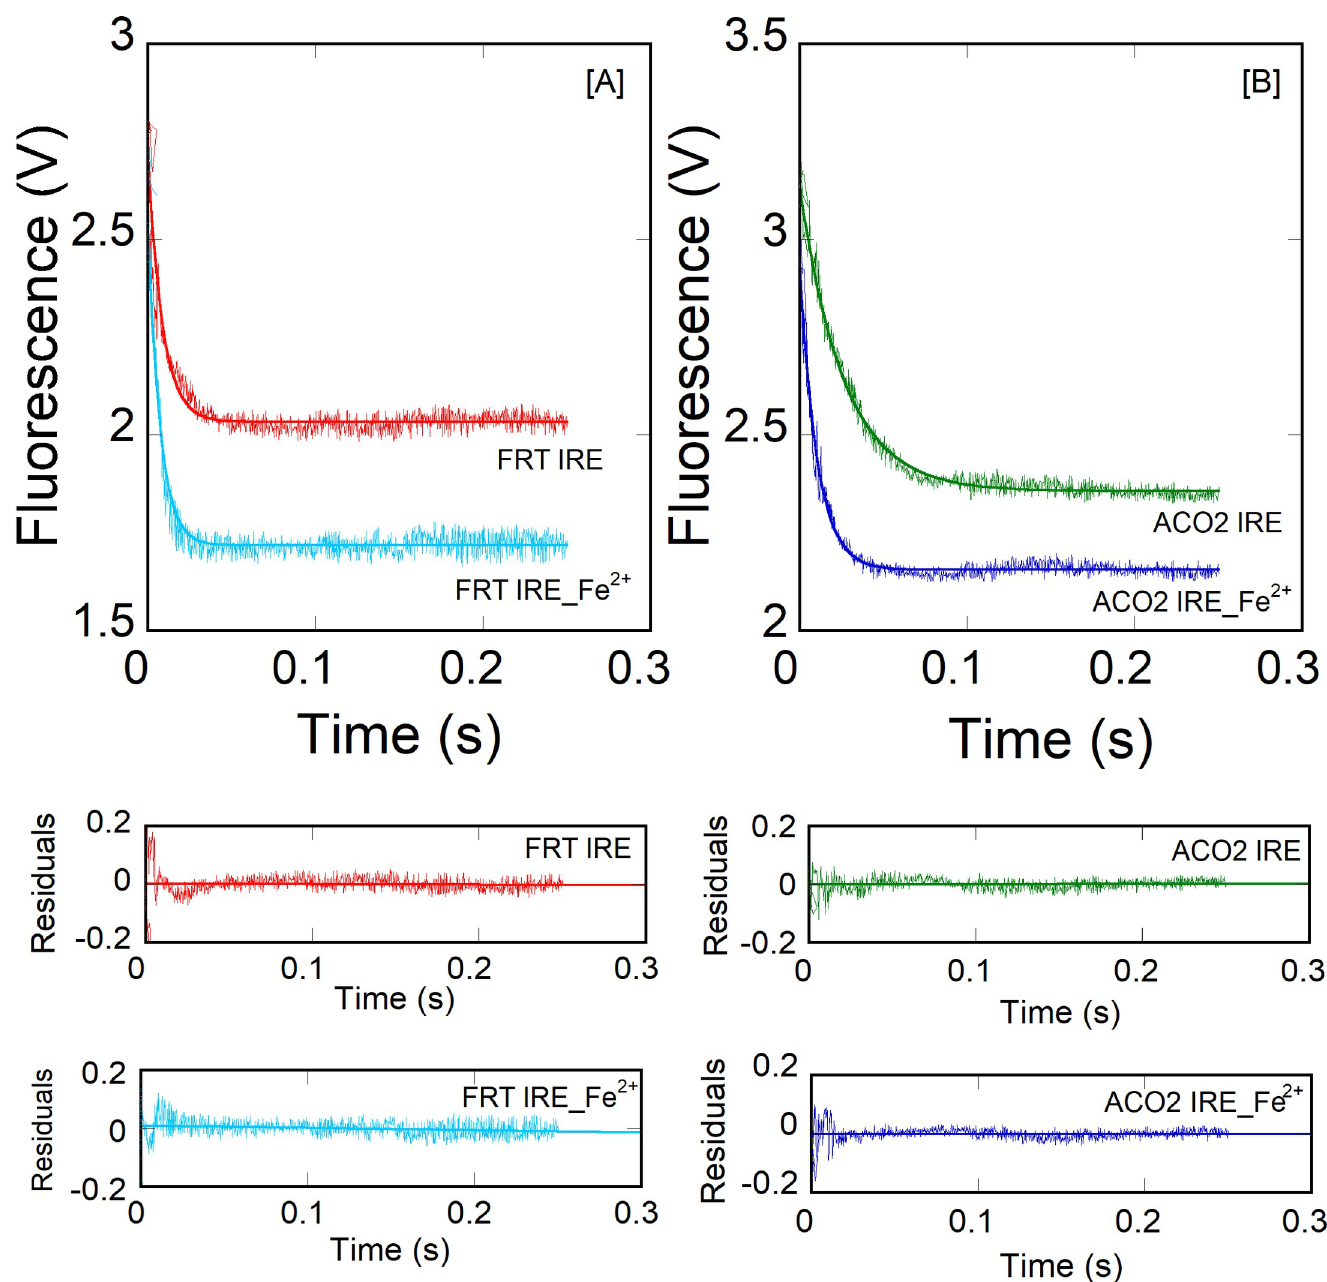
Fig 3. Iron enhances kinetic rates for the interaction of IRE RNA with eIF4F. eIF4F at 0.1 μ m (final) was mixed with (A) FRT IRE RNA (B) ACO2 IRE RNA with or without addition of 50 μ M (final) Fe 2+ at 20 ˚C. Concentration of IRE RNA was 1 μ M (final). Solid line represents the fitted line drawn through the data points was fit by assuming a single exponential process. Residuals for the fits are shown in the lower panels . Addition of iron increases the binding rates of FRT and ACO2 IRE RNA-eIF4F complex 2-fold. https://doi.org/10.1371/journal.pone.0250374.g003 rates of the eIF4F � IRE RNA-Fe 2+ complex at 25˚C were about 3.5-fold faster as compared to 5˚C (Table 1). The temperature-dependent kinetic data showed that ferritin IRE RNA had consistently higher binding rates compared with the mitochondrial aconitase IRE RNA with and without iron.